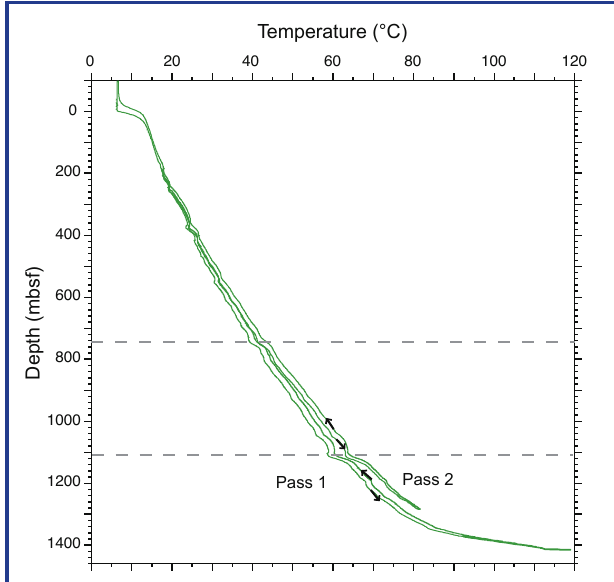
Figure 6. Temperature recorded by TAP tool. Increase in borehole temperature with time is recorded during downhole and uphole logging runs and during repeated logging passes. Dashed lines indicate recognized fault zones (see Fig. 2) which coincide with local dips in